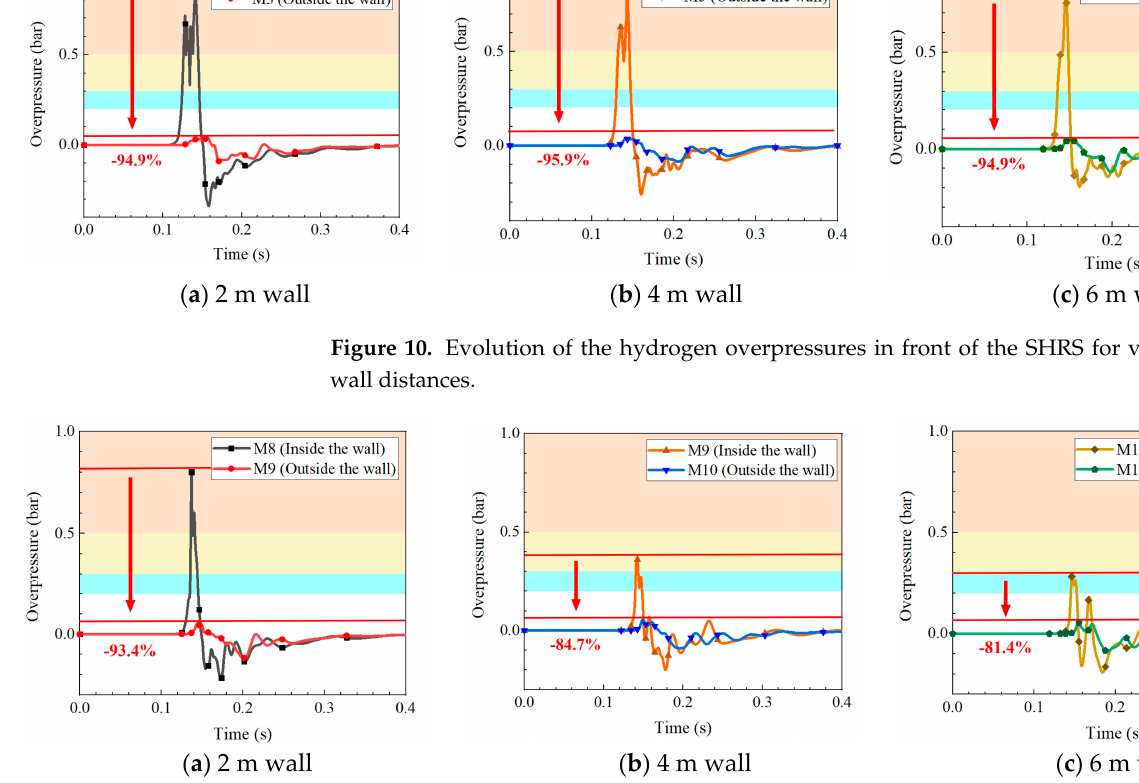
Figure 11. Evolution of the hydrogen overpressures on the side of the SHRS for various protective wall distances. wall